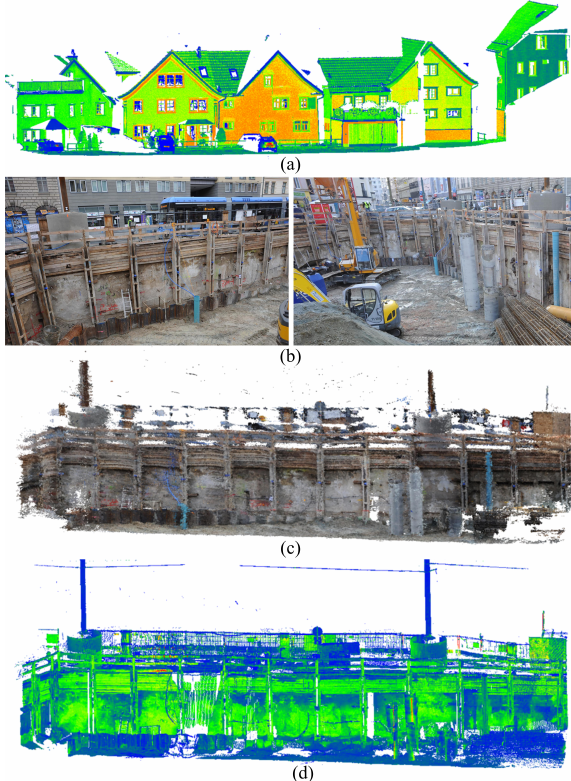
Figure 5. (a) LiDAR point cloud of the building facade scene. (b) Real scene of the construction site. (c) Photogrammetric and (d) LiDAR point clouds of the construction site scene.